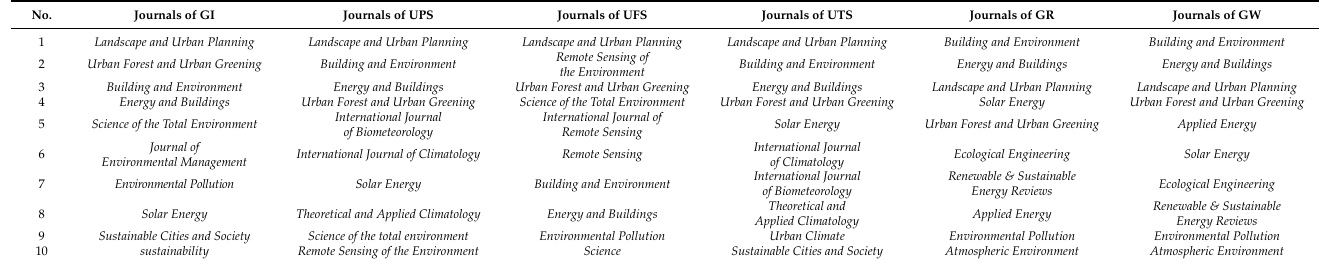
Table 4. Top 10 journals by publications on different GI types, 1990–2021.